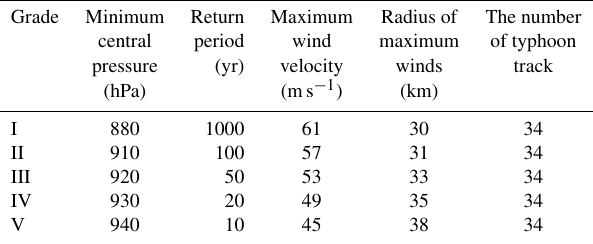
Table 5. Constructed storm scenarios with different intensities. Table 6. Hazard zone classification according to the inundation